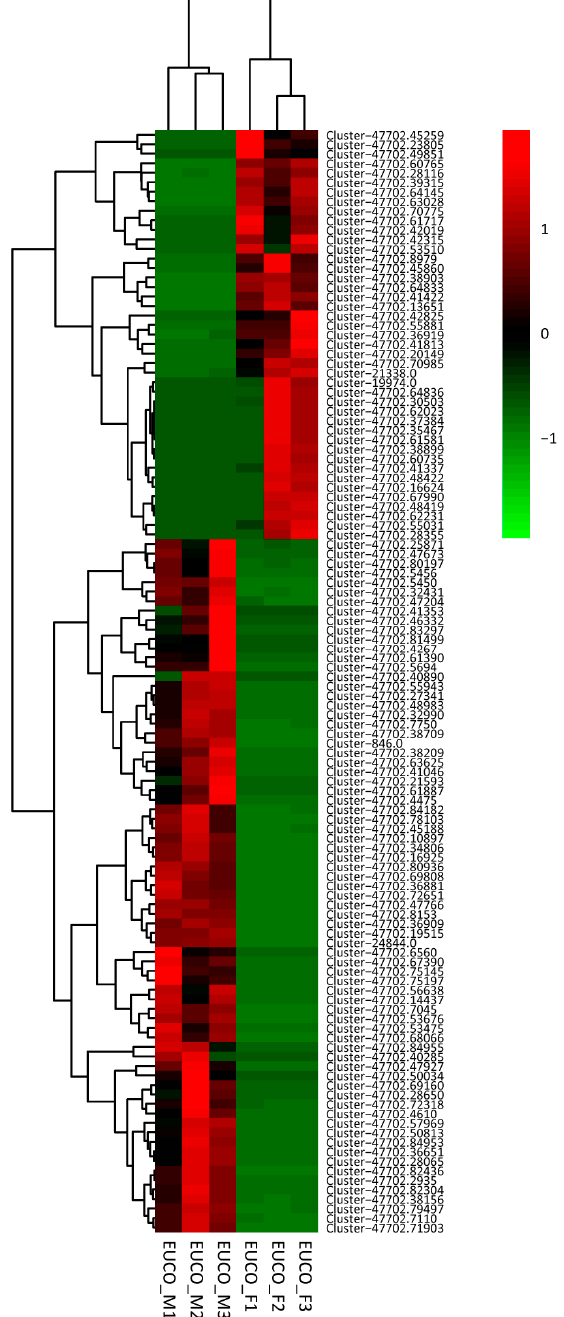
Figure 3. Heat map diagram of expression patterns for 116 DEGs (differentially expressed genes) between the males and the females of Eucommia ulmoides . The color from red to green indicates the gene expression level towards small. EUCO_M: Males, EUCO_F: Females; the numbers 1/2/3 represent different individuals.